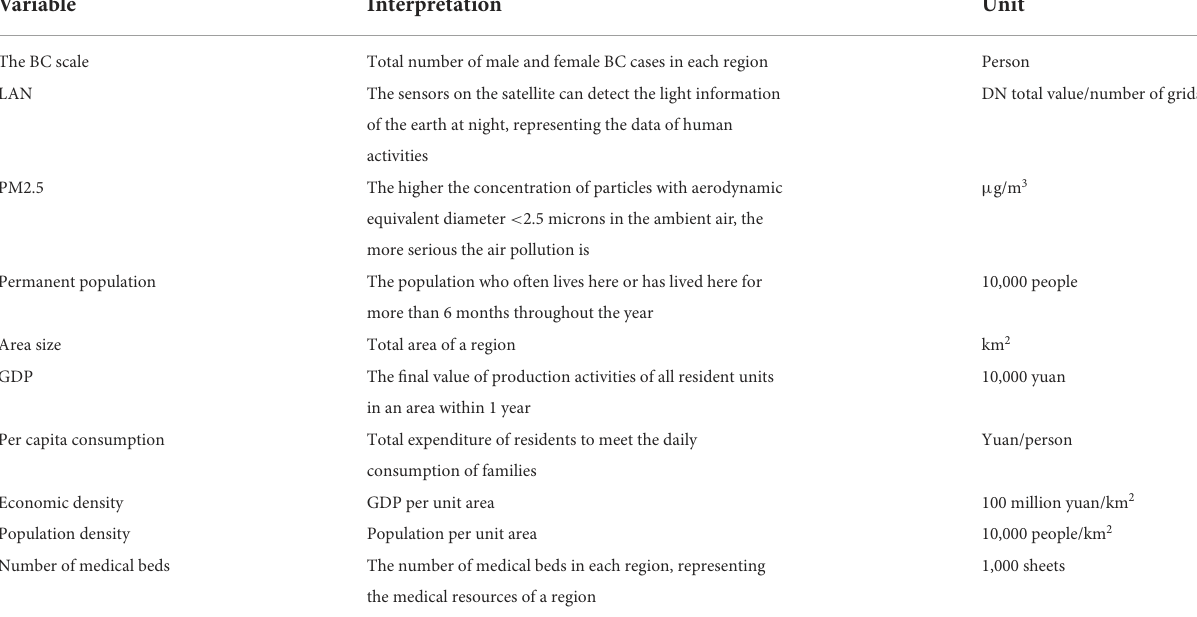
TABLE 2 Description of various